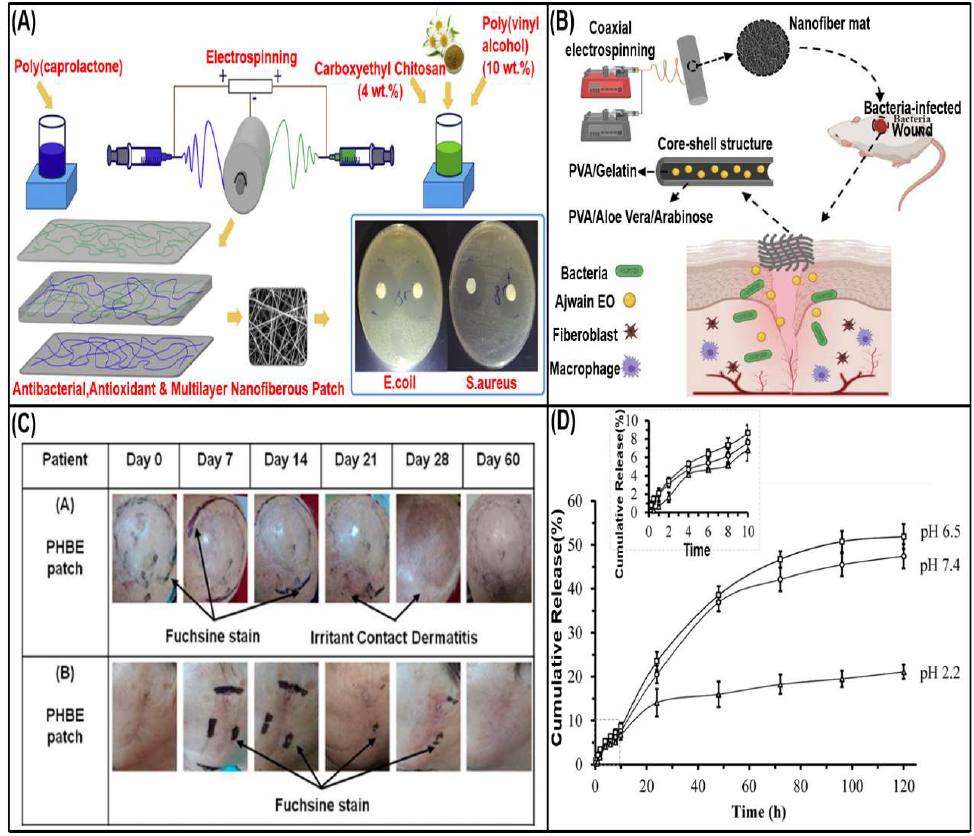
Figure 8. Polysaccharide polymer-loaded herbal medicine nanofibers. ( A ) Electrospun CECS/PVA/chamomile extract nanofibers, reprinted with permission from [209] copyright 2020, Elsevier. ( B ) A schematic diagram of the preparation, structure and use of core-shell nanofiber mats, reprinted with permission from [221] copyright 2021, Elsevier. ( C ) PHBE patch therapy, reprinted with permission from [224] copyright 2021, Cancers. ( D ) X-Ch nanofibers release curcumin, re- printed with permission from [225] copyright 2018, Elsevier.